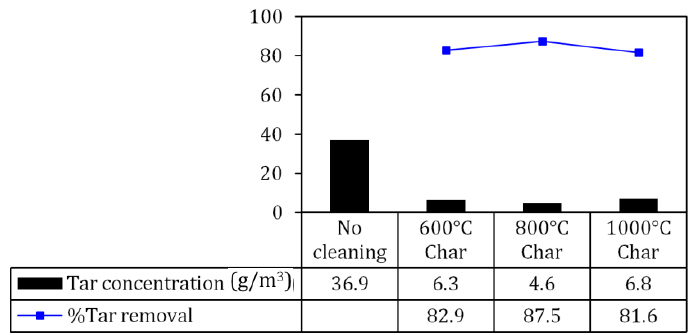
Figure 6. Concentration of heavy tar in the pyrolysis gas before (described as—no cleaning) and after the adsorption bed of each type of